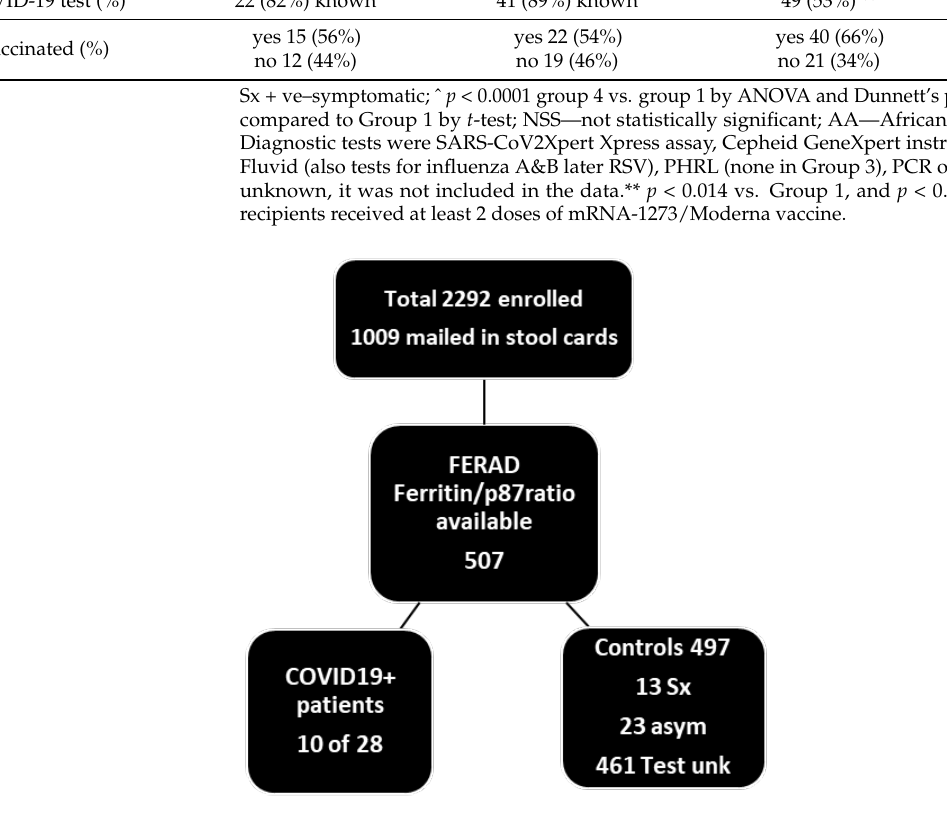
Figure 1. Flow diagram of patients who submitted stool cards and had ferritin levels for a FERAD calculation. Less than 50% of patients turned in cards, and only 507 of those had ferritin concentration levels determined opportunistically and available from the computerized patient record system (CPRS). FERAD ratios in symptomatic (Sx) and asymptomatic (asym) patients totaled 36 and 461, where the results of a PCR COVID-19 test were unknown (unk). The proportion of stool cards delivered by postal mail was not substantially different from the known return proportion of 44% for occult blood card return, as determined for that time period at the Detroit VAMC. Table 1. Demographics and hospitalization data in COVID-19 and control groups.